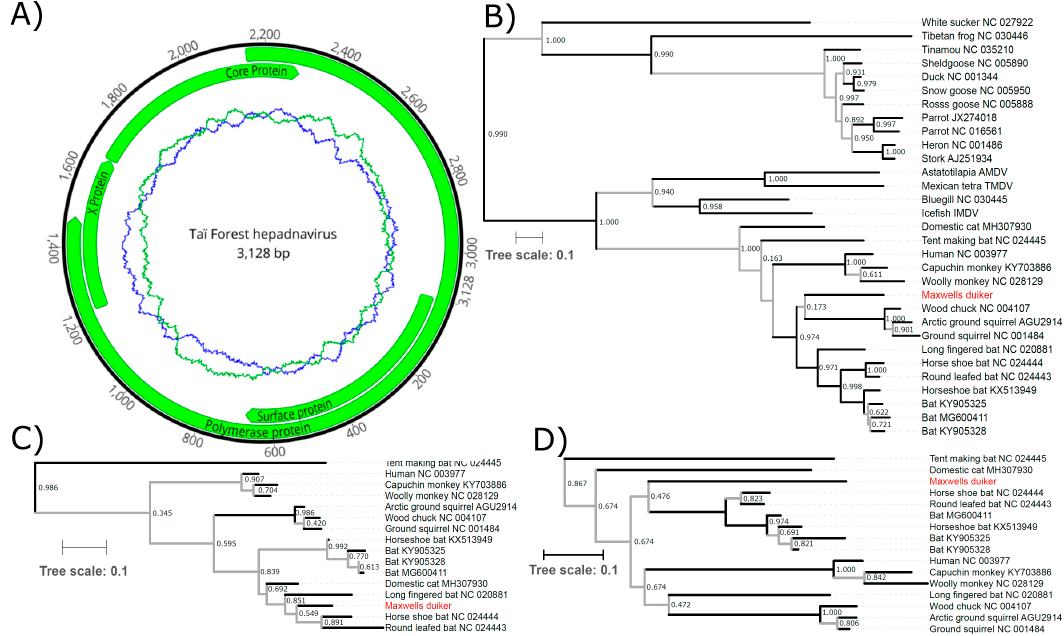
Figure 1. ( A ) The genome organization of Taï Forest hepadnavirus. The innermost circles represent the GC (blue) and AT (green) content along a 50 nt sliding window. ( B ) Phylogenetic relationship of Taï Forest hepadnavirus to other viruses of the family Hepadnaviridae. Maximum likelihood phylogeny constructed using the amino acid sequence of the polymerase ORF from a range of vertebrate hepadnaviruses; and ( C ) using the core and ( D ) the surface protein ORFs in comparison to the mammalian orthohepadnaviruses; the common name of the host is indicated at the branch labels, along with each virus’s accession number. GenBank sequences were aligned to Taï Forest hepadnavirus ORF sequences using MAFFT (v7.307) and we selected conserved blocks using Gblocks, as implemented in SeaView V4 [28]. PhyML with smart model selection [29], and the Bayesian Information Criterion and subtree pruning and regrafting (SPR) was applied as the tree improvement approach, with otherwise default settings for tree building (selected models: polymerase ORF = LG + G + I + F; core ORF = JTT + G; surface ORF = JTT + G + F). We estimated the